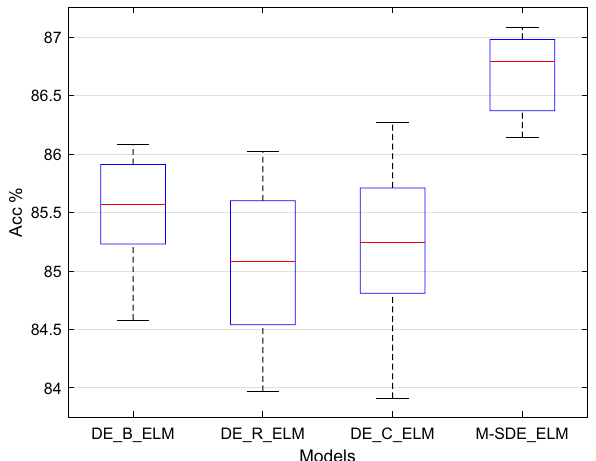
Figure 11. Comparison single-strategy models with multi-strategy models.